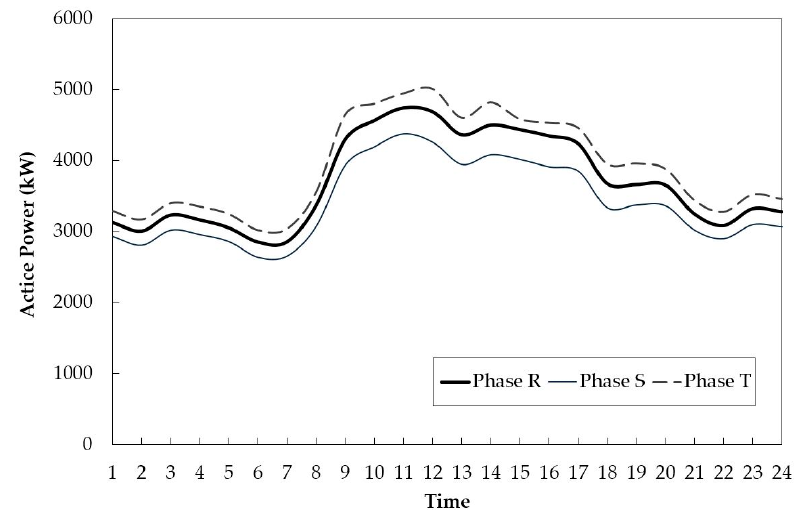
Figure 10. Daily unbalanced three-phase active power consumption at Bus 1.